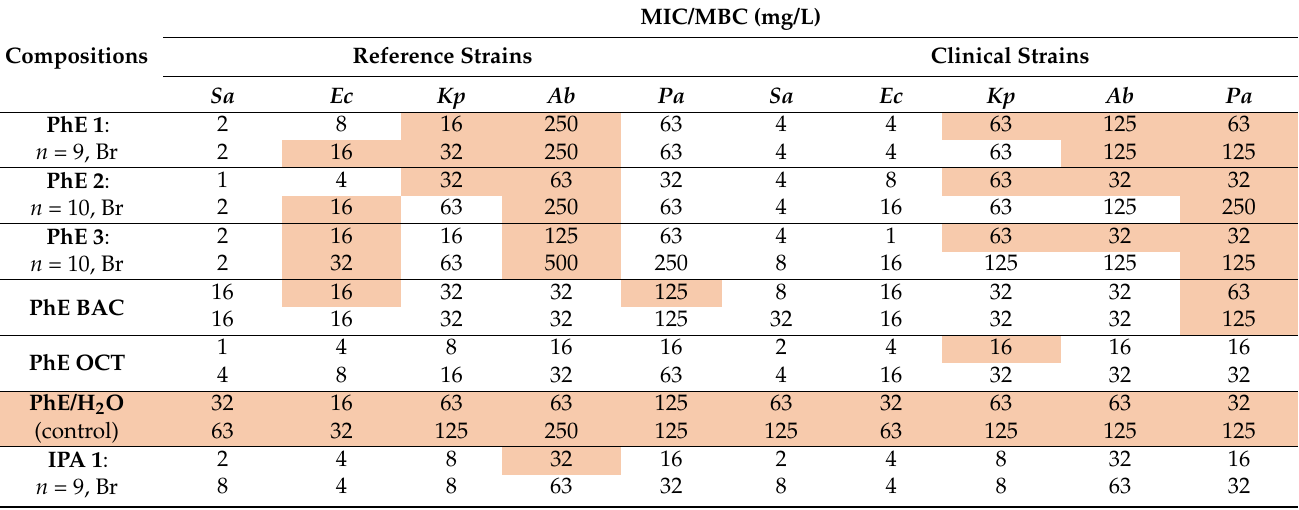
Table 5. Antibacterial activity of QACs with different alcohols against